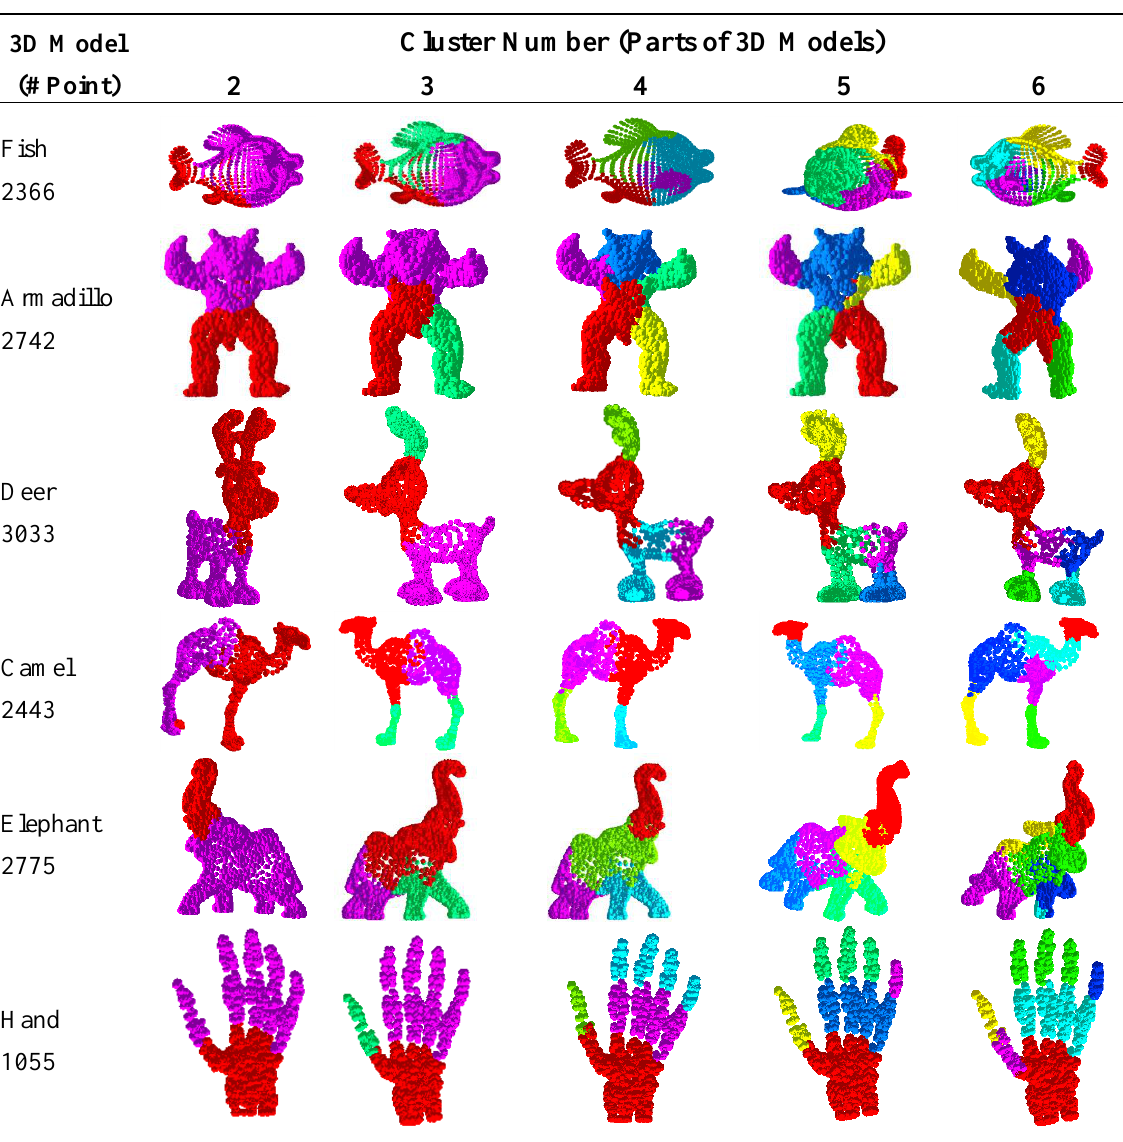
Table 4. Segmentation results with different cluster class